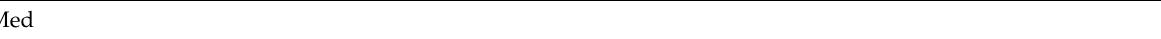
Table 1. Search strategies for each